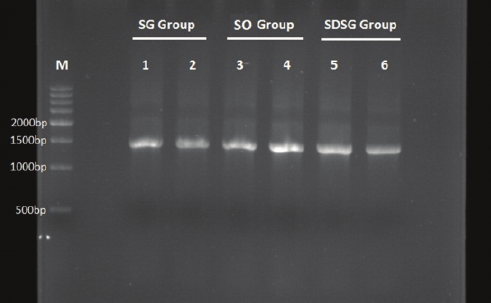
Figure 4: PCR amplification results of 16S rRNA gene 1 month after different operation procedures. Sleeve gastrectomy group (SG), sham-operation group (SO), and sleeve gastrectomy of SD rats group (SDSG).